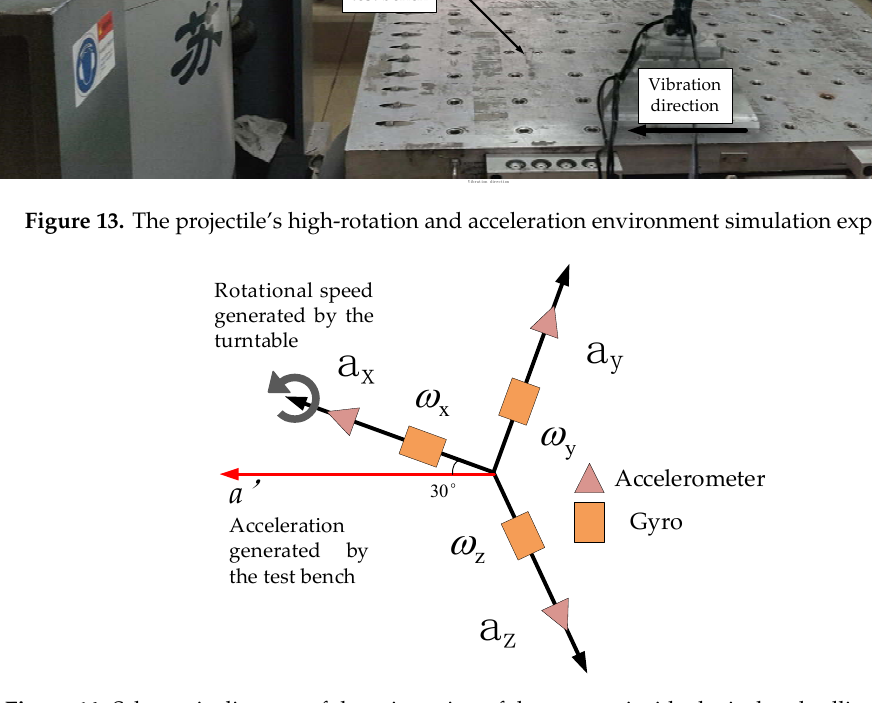
Figure 14. Schematic diagram of the orientation of the sensors inside the isolated rolling platform.